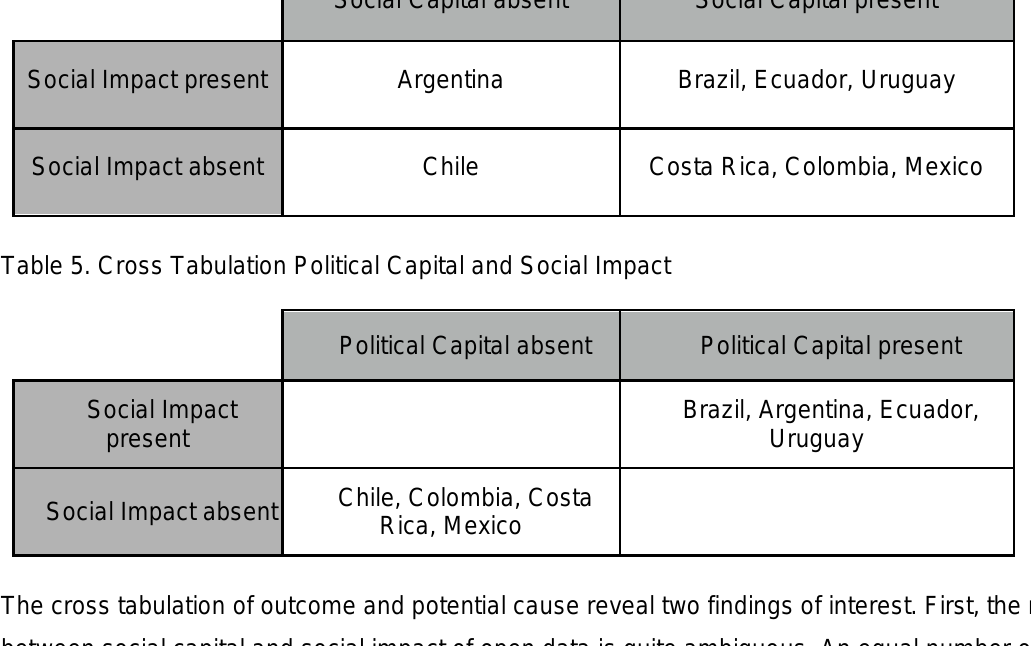
Table 4. Cross Tabulation Social Capital and Social Impact Social Capital absent